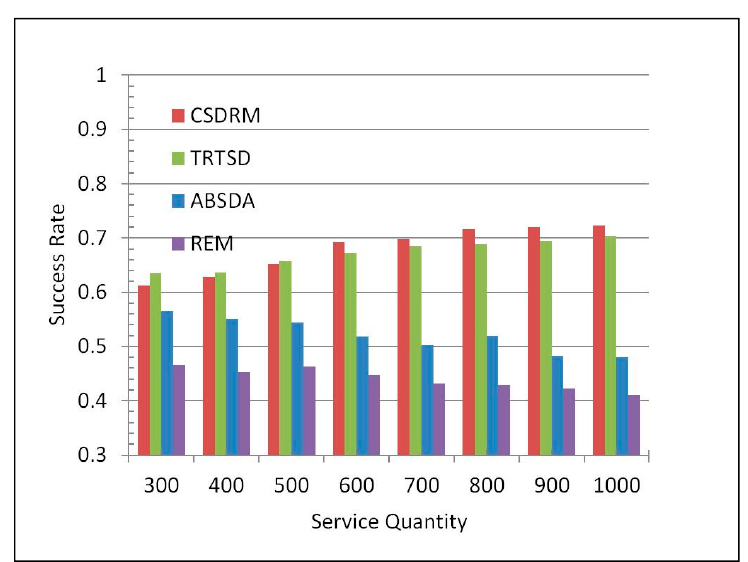
Figure 7. Comparison of precision.